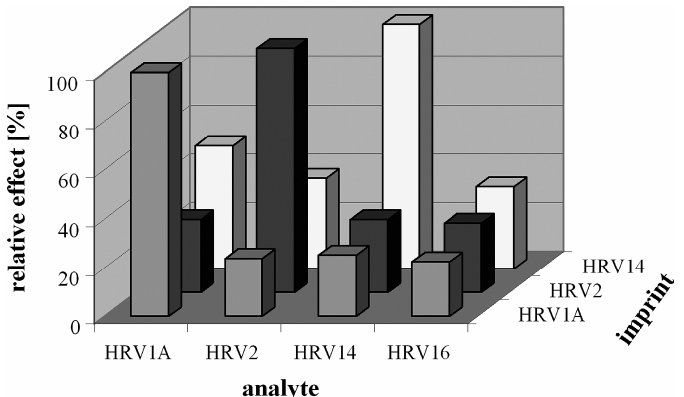
Figure 5. Comparison of relative sensor signals of three different MIP layers imprinted with HRV1A, HRV2 and HRV 14, respectively, is shown. When exposed to HRV1A, HRV2, HRV 14 and HRV 16, all three sensor layers showed the highest signal to virus that was used as a template for imprinting while the response for other serotypes were much lower despite of their similar geometries, reproduced with permission from [117].